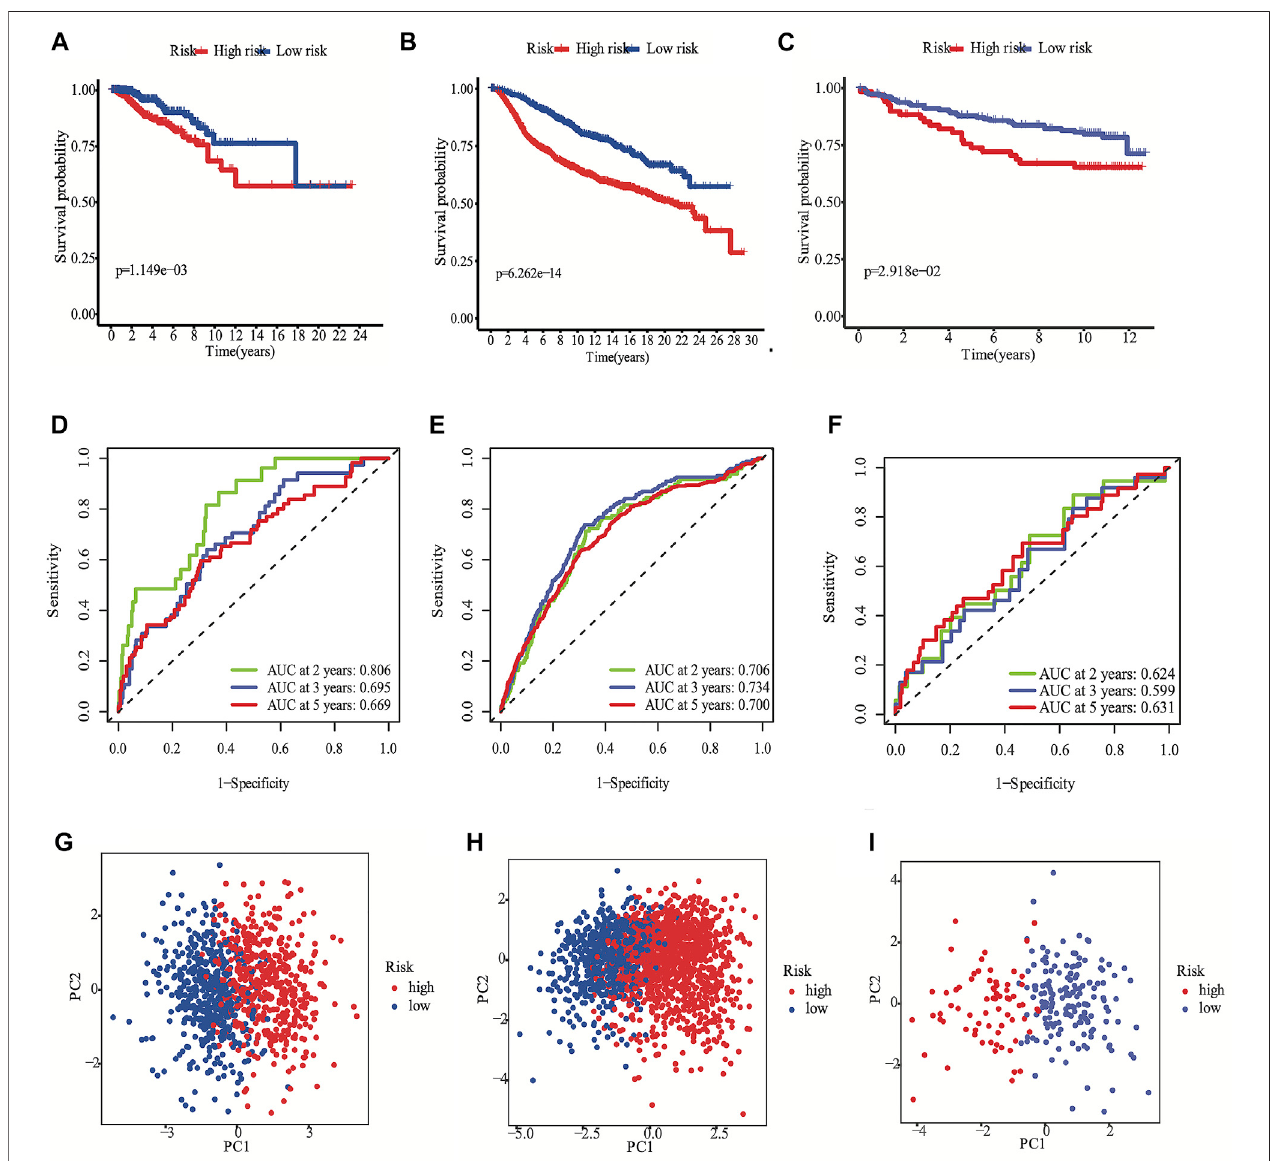
FIGURE 3 | Development the prognostic FRG panel in TCGA cohort (A, D, G) . Validation the prognostic FRG panel in METABRIC cohort (B, E, H) and GSE3494 cohort (C,F,I) .TheKaplan-MeiercurveshowedthattheDSSofthehigh-risksubgroupwassubstantiallyshorterthanthatofthelow-risksubgroup (A,B,C) .AUCtime- dependent ROC curves for DSS (D, E, F)